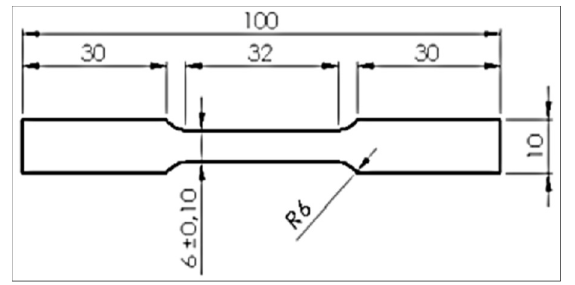
Fig. 3. Tensile test machine according to ASTM E8- M . All dimensions in millimeters.